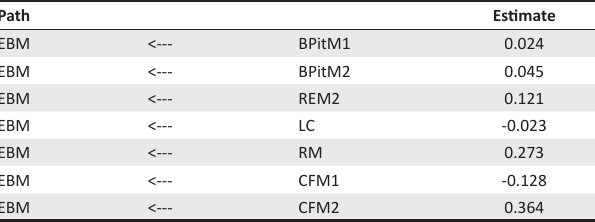
TABLE 11: Interpretation of regression weights.